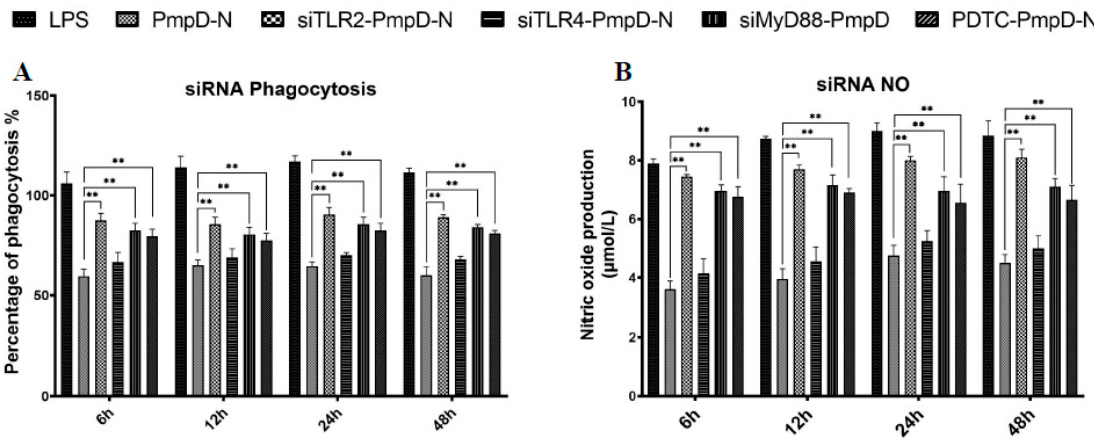
Figure 8. Effect of siRNA or treatment with the NF- κ B inhibitor on phagocytic function and NO production in HD11 cells. HD11 cells were transfected with siRNA targeting TLR2, TLR4, and MyD88 or treated with the NF- κ B inhibitor PDTC before stimulation with PmpD-N. Phagocytic ( A ) function and NO ( B ) production were determined in cell supernatants. Each experiment was repeated at least twice. Data are shown as the mean ± SD values for triplicate cultures for one of two independent experiments. Statistically significant differences among different groups were analyzed with one-way analysis of variance (ANOVA) with Tukey’s post hoc multiple comparisons test.